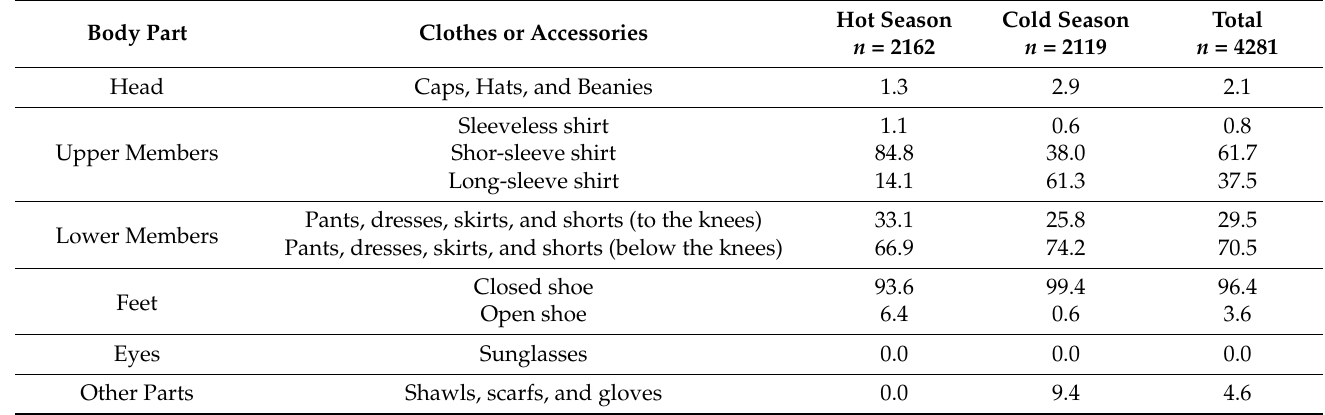
Table 2. Frequency (%) of wearing PhP clothing and